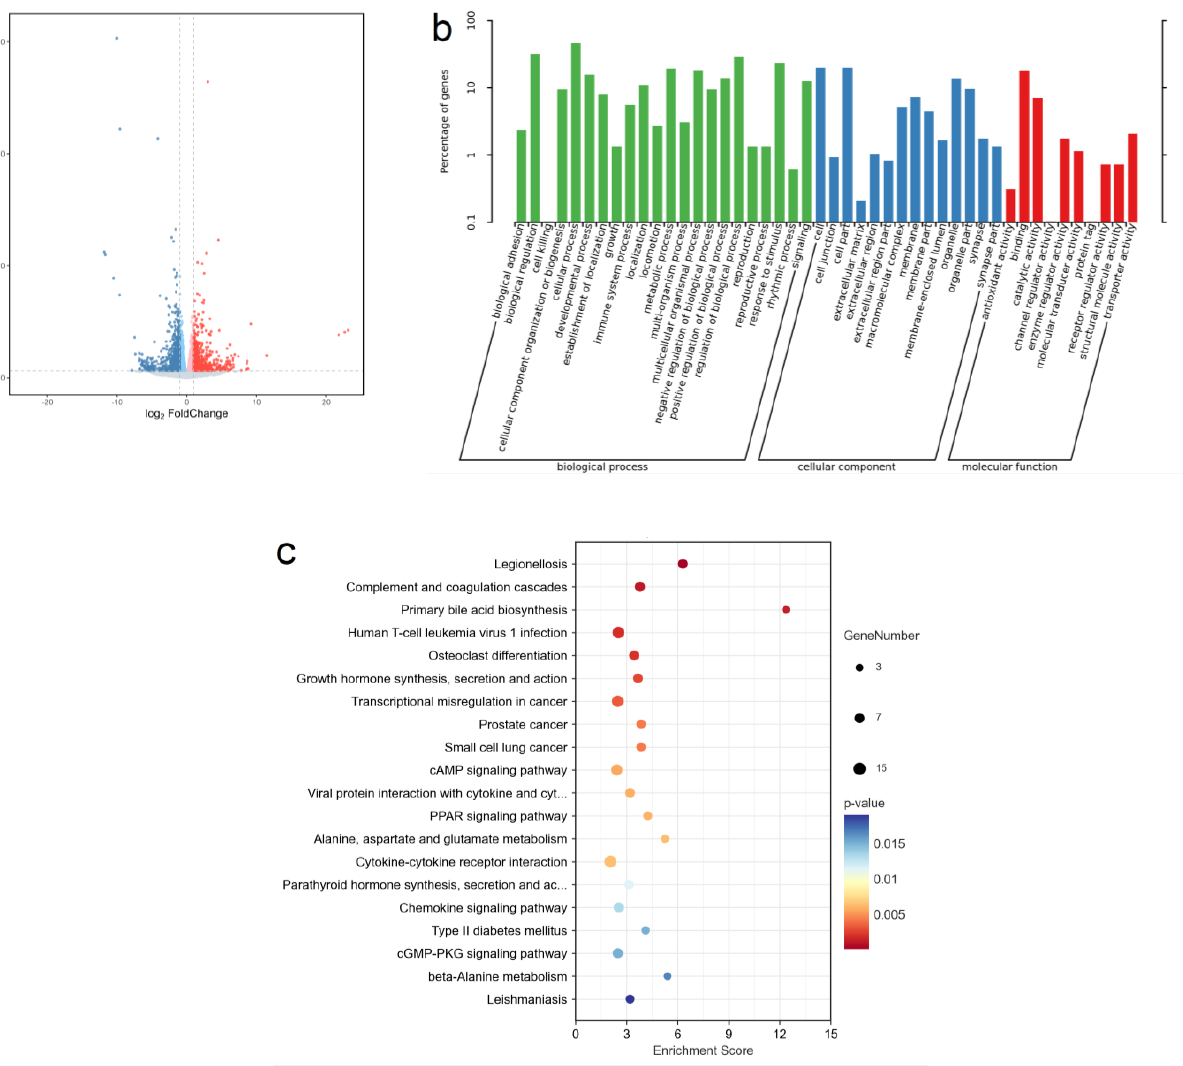
Figure 3. ( a ) Volcano plot of gene expression in the subcutaneous fat of SF yaks in contrast to GF yaks. The abscissa represents the value of log 2 FC, and the ordinate represents the value of −log 10 P . A point represents a gene. The points with FC > 2.0 and p < 0.05 or FC < 0.5 and p < 0.05 are shown in red or blue, respectively; non-differentially expressed genes (DEGs) are shown in black. ( b ) The top 30 terms for gene ontology (GO) enrichment for DEGs in the subcutaneous fat of SF yaks in contrast to GF yaks. ( c ) The top 20 terms for KEGG pathway enrichment analysis for DEGs in the subcutaneous fat of SF yaks in contrast to GF yaks. Table 3. The information of crucial differentially expressed genes (DEGs) in the regulation of fat metabolism in yak subcutaneous fat.